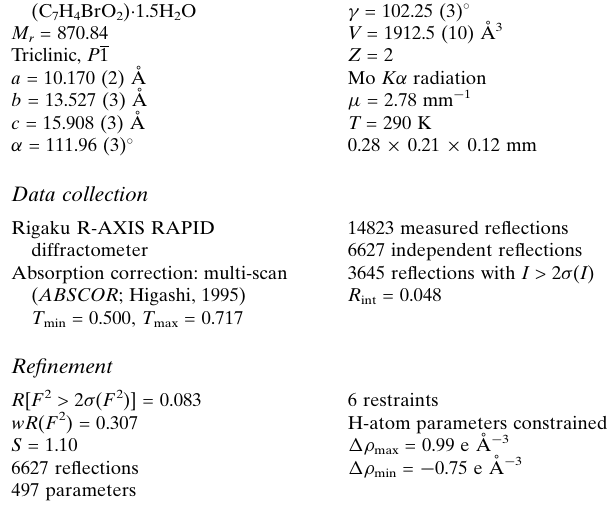
Data collection Rigaku R-AXIS RAPID diffractometer